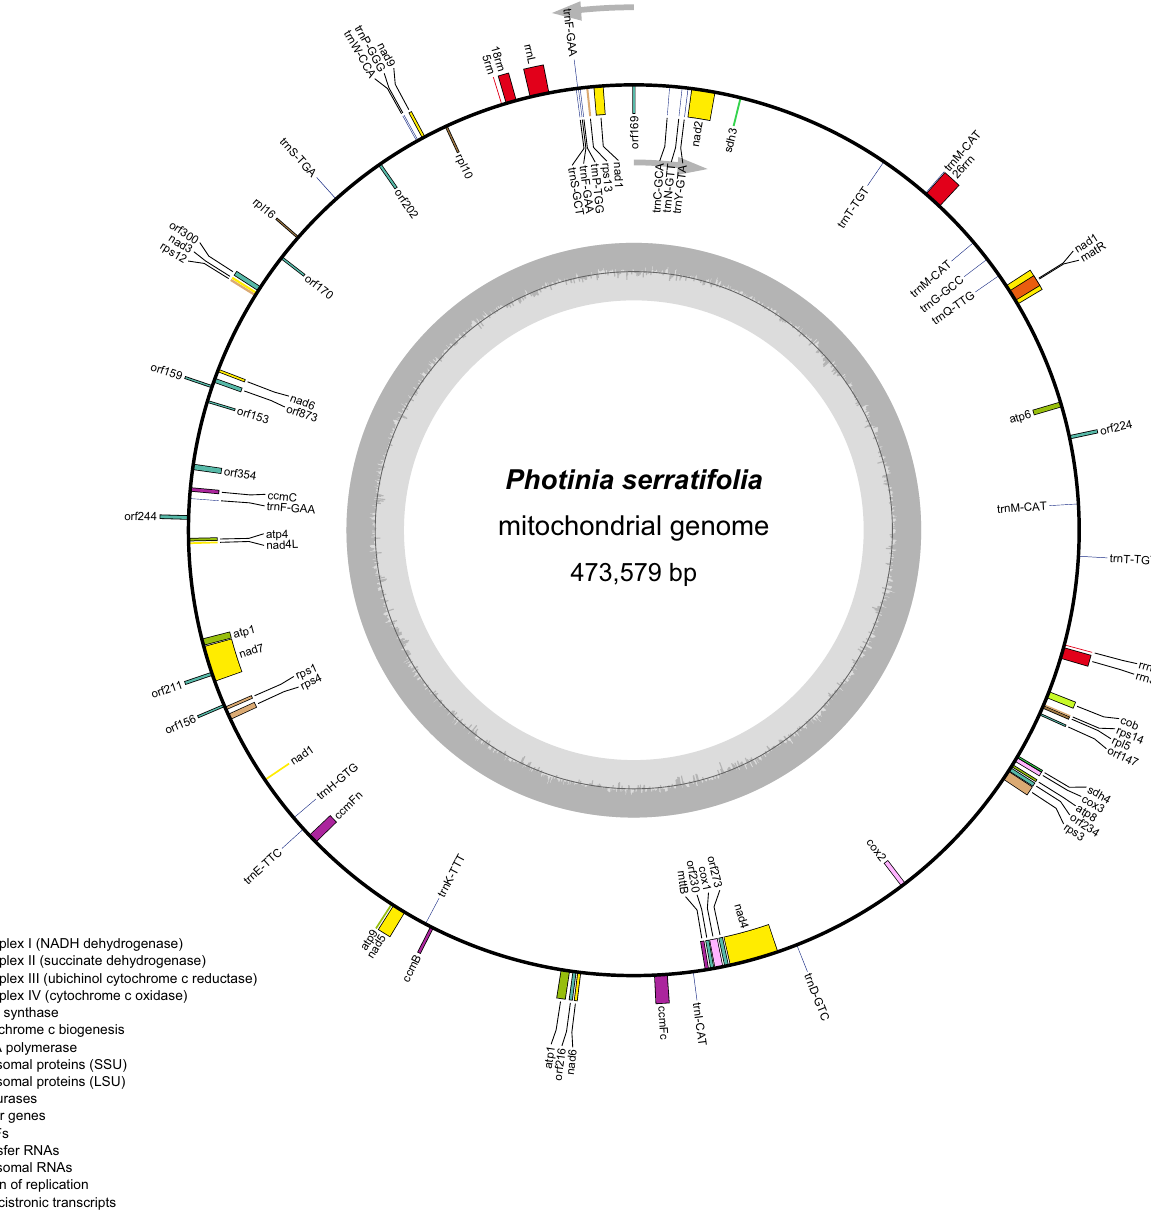
Figure 1. The circular map of P. serratifolia mitogenome. Gene map showing 68 annotated genes of different functional